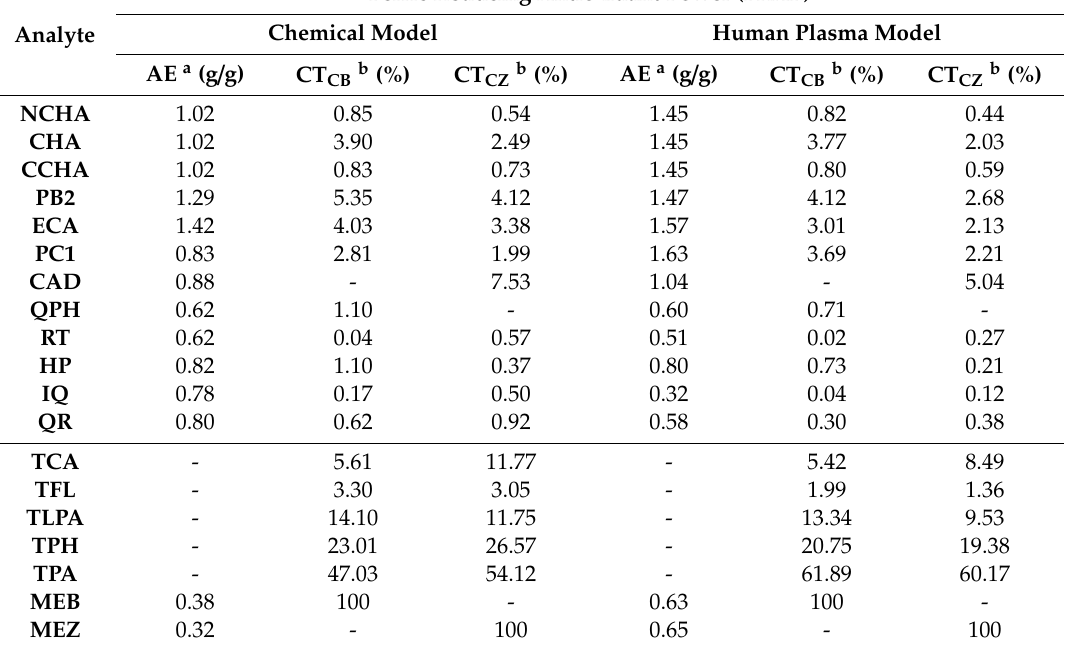
Table 4. Contribution of individual phenolics and groups of phenolics to the antioxidant activity (FRAP) of the C. bullatus and C. zabelii extracts in chemical and biological